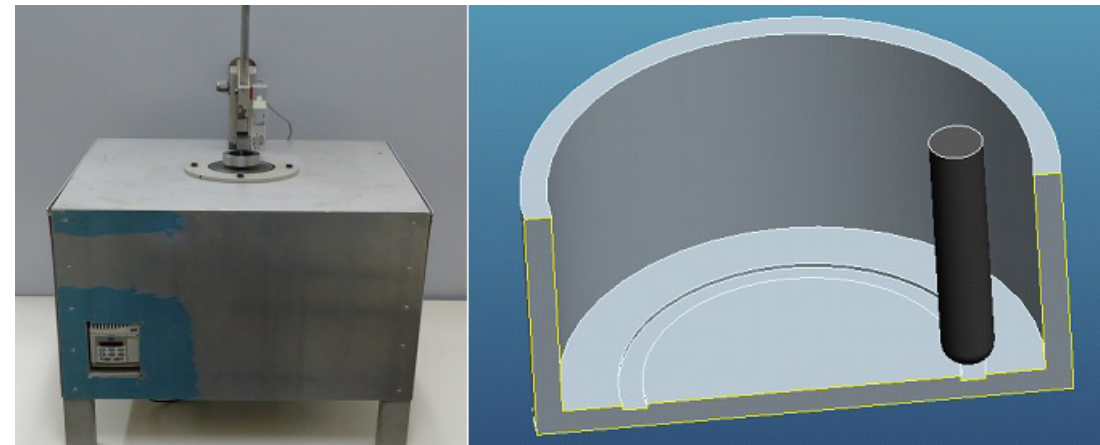
Figure 1. Pin on disk